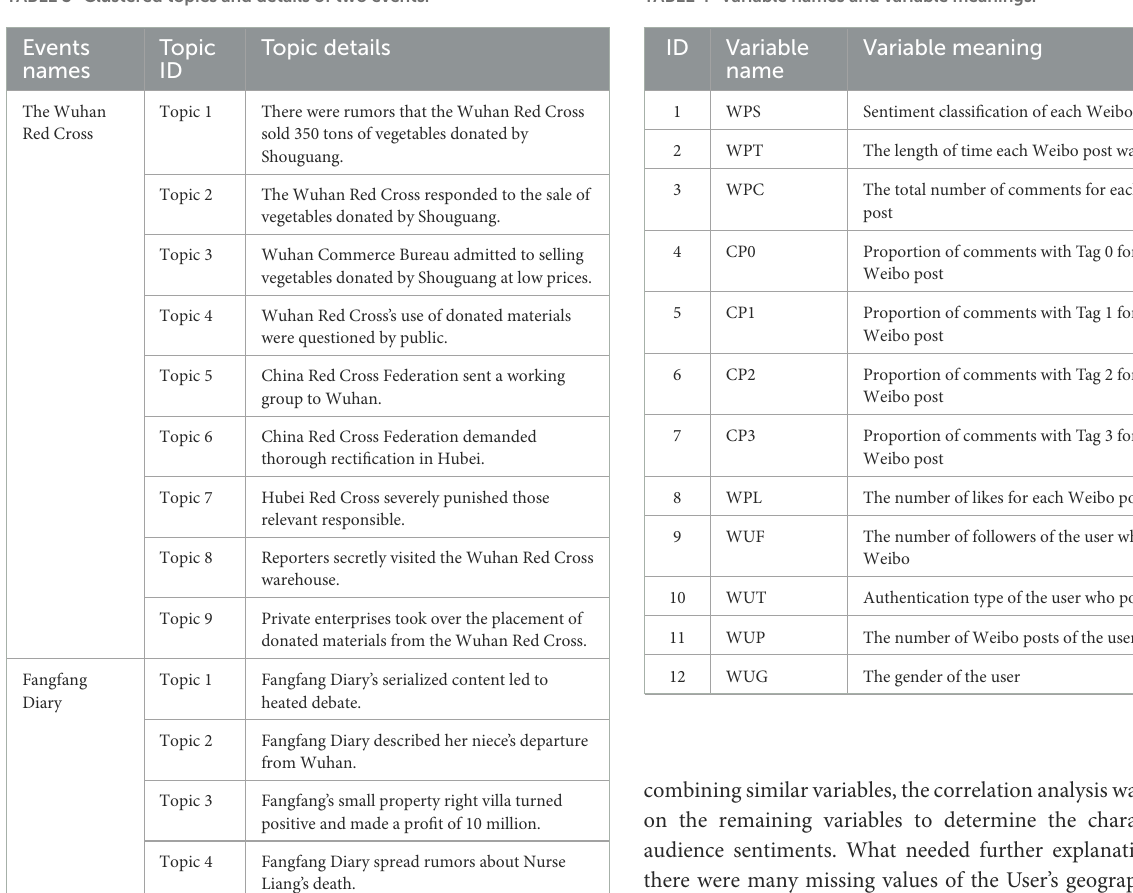
TABLE 3 Clustered topics and details of two